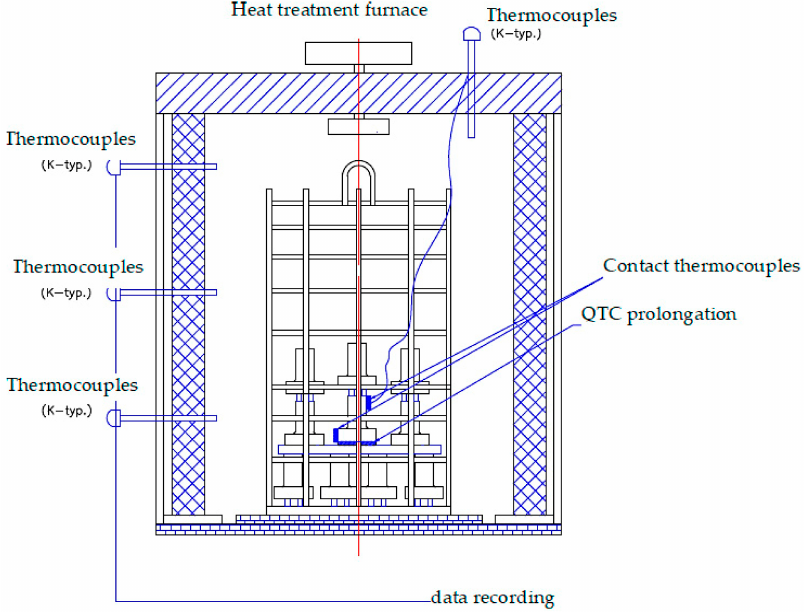
Figure 2. The heat treatment furnace [1].